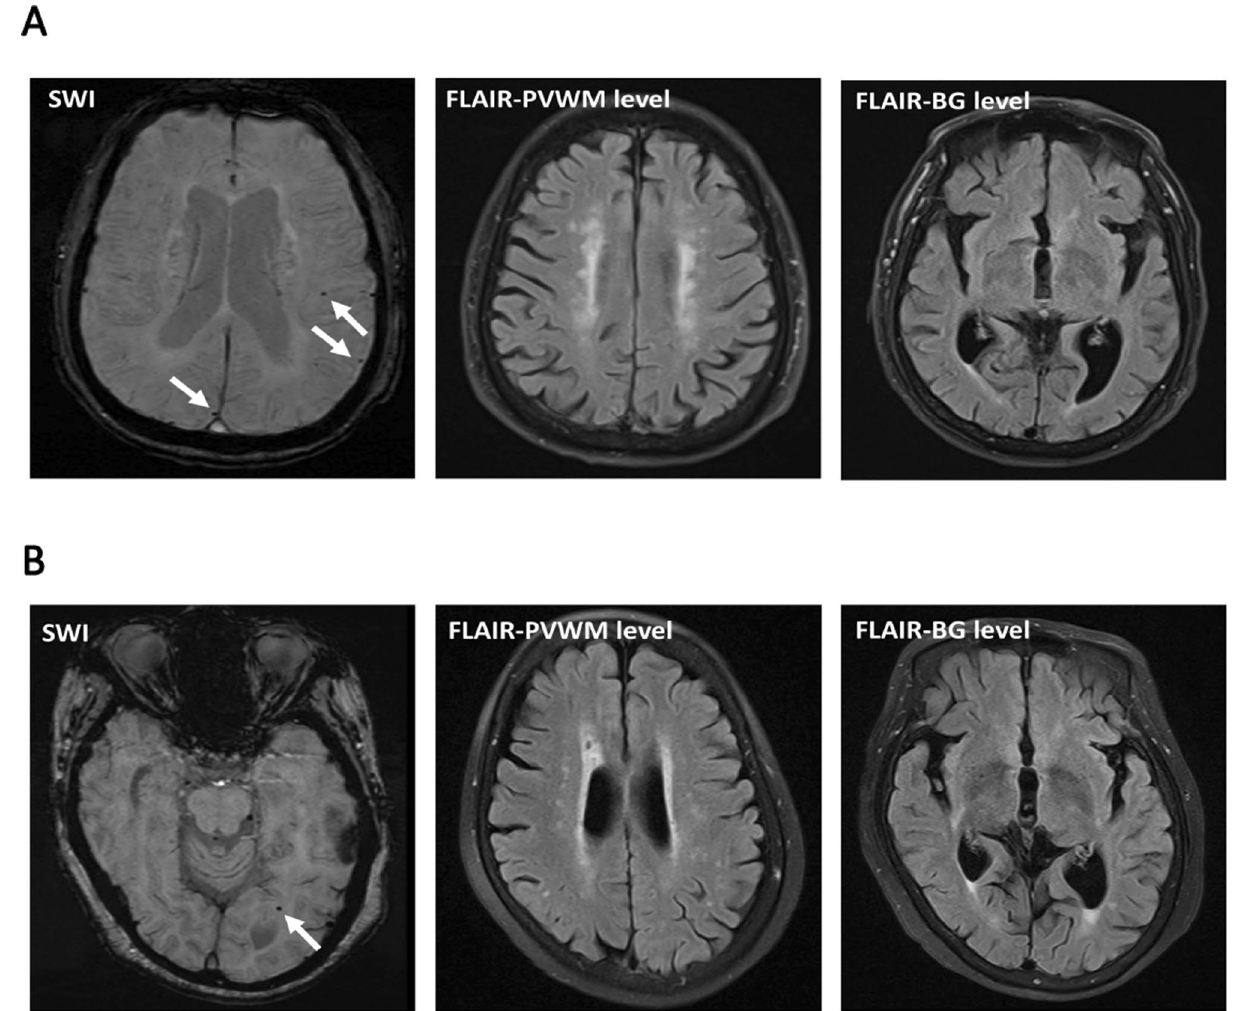
Figure 1. Representative images of lobar microbleeds in Parkinson’s disease. ( A ) A 66-year-old woman with Parkinson’s disease dementia (PDD, MMSE score 23) had multiple lobar microbleeds in the left parietal and right occipital lobes (arrow) and minimal white matter hyperintensity (WMH) on fluid-attenuated inversion recovery imaging. There was no lacunar infarct over bilateral BG. ( B ) An 82-year-old woman with PDD (MMSE score 16) had one lobar microbleeds in the left occipital (arrow), the left parietal, and the right temporal lobes (not shown). Mild WMH was also seen on fluid-attenuated inversion recovery imaging. There was no lacunar infarct over bilateral BG. SWI susceptibility weighted imaging, FLAIR fluid-attenuated inversion recovery imaging, PVMW periventricular white matter, BG basal